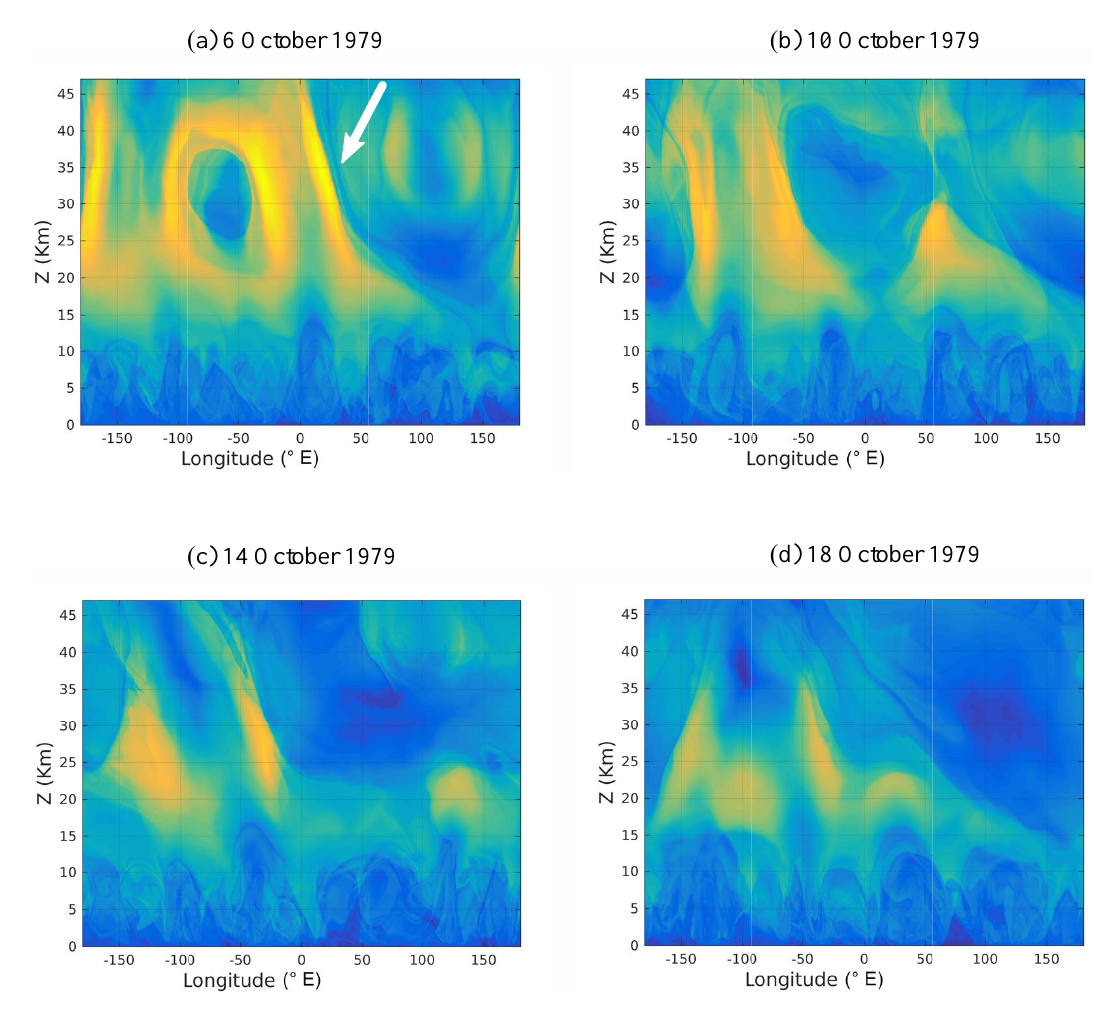
Figure 8. Vertical slices showing M for τ = 5 at constant latitude 60 ◦ S on 4 selected days in October. The colour scale is the same in all